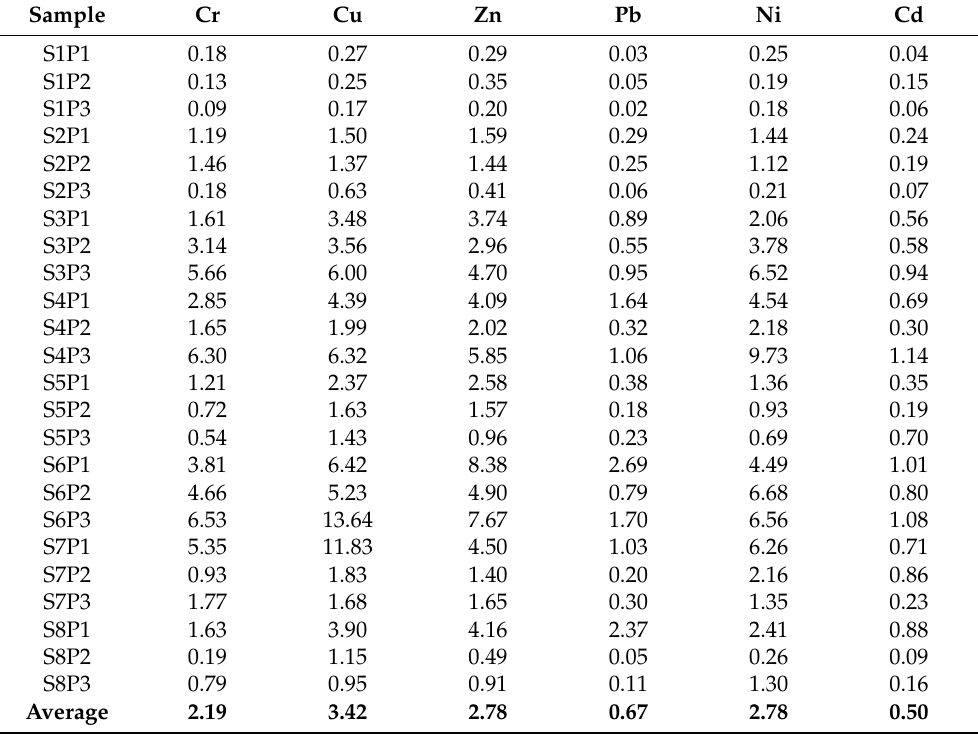
Table 5. Pollution index summary for each of the sites.